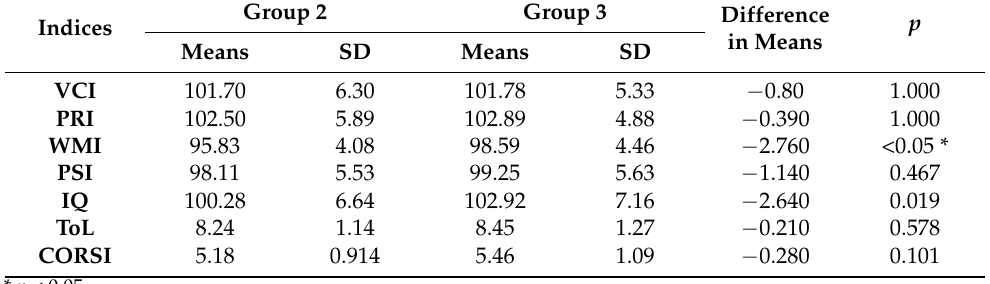
Table 5. Post hoc comparisons between group 2 and 3.